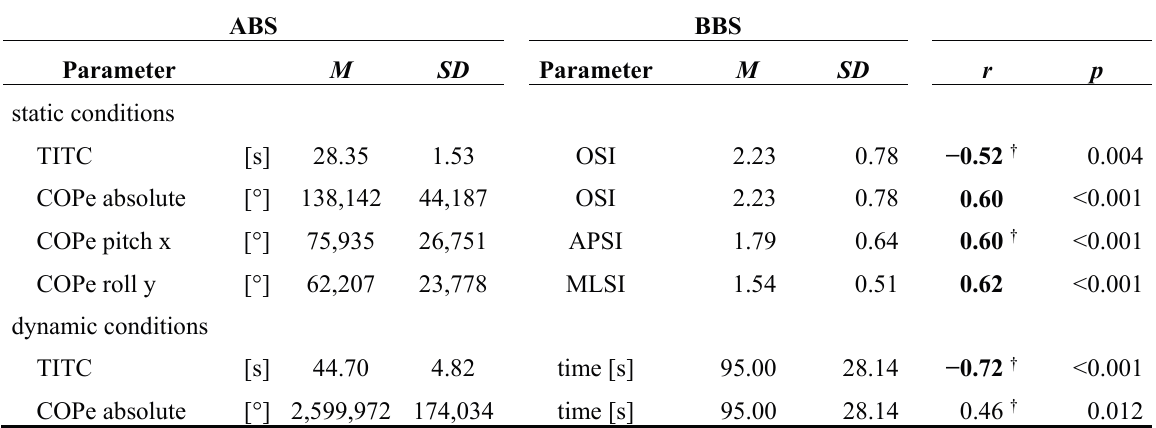
Table 4. Analyses of the ABS in comparison with BBS in static and dynamic conditions ( n =